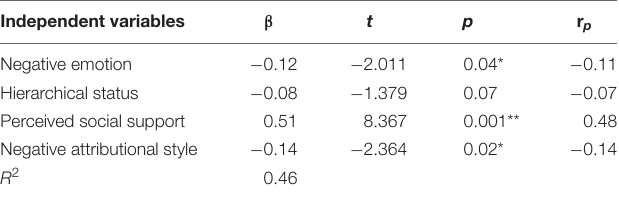
TABLE 3 | Results of regression equation for predictive purpose in the case of reconciling